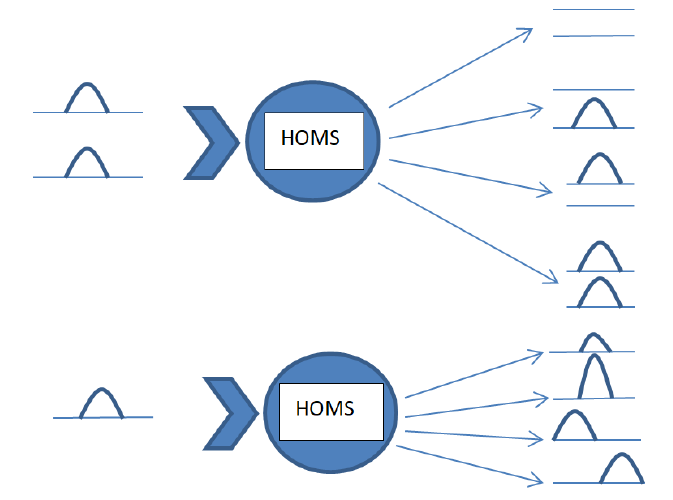
Figure 7. A schematic figure of the possible functions that can be realized by the proposed system.